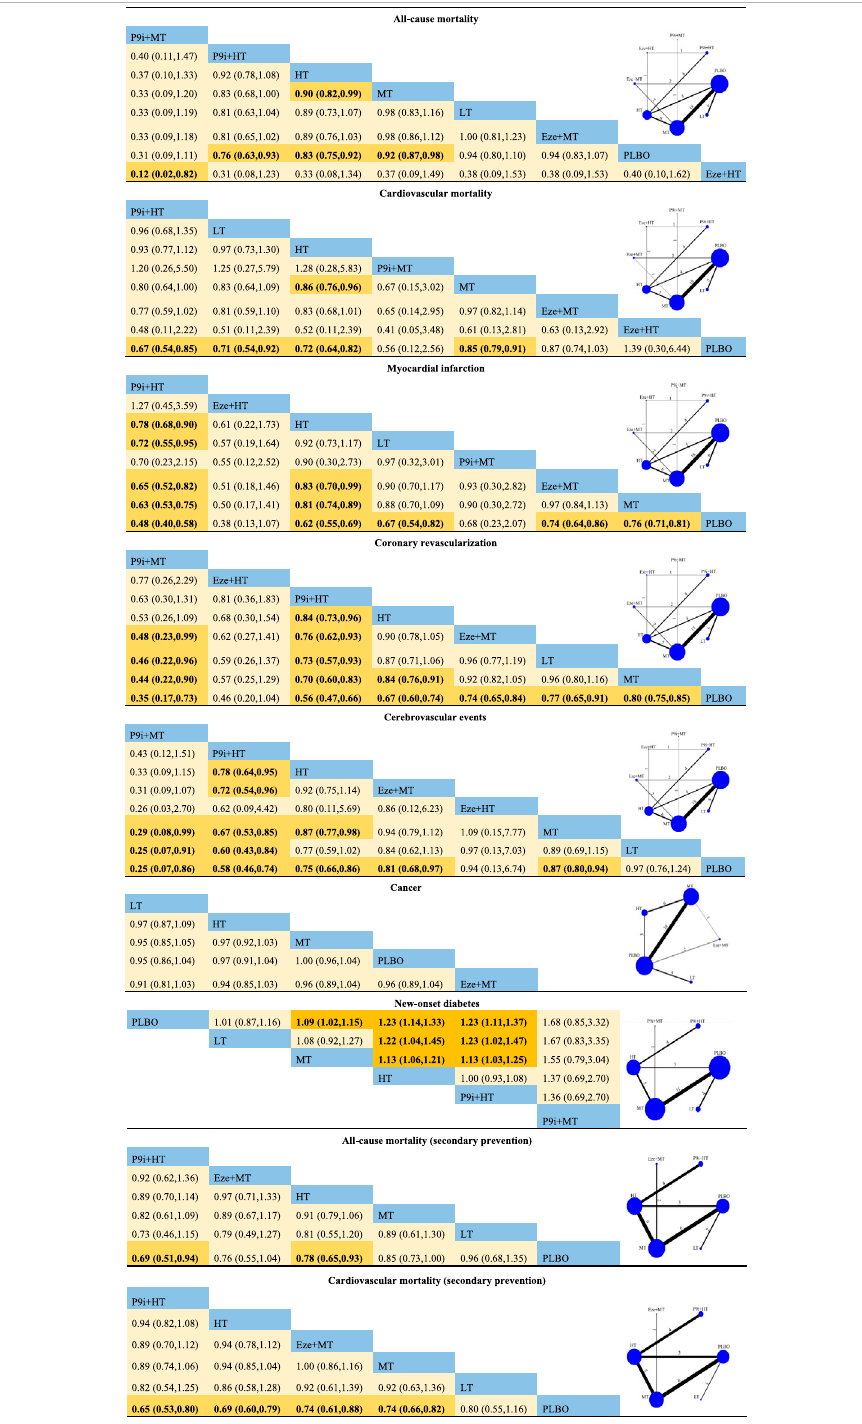
TABLE 2 | Network meta-analysis for clinical outcomes